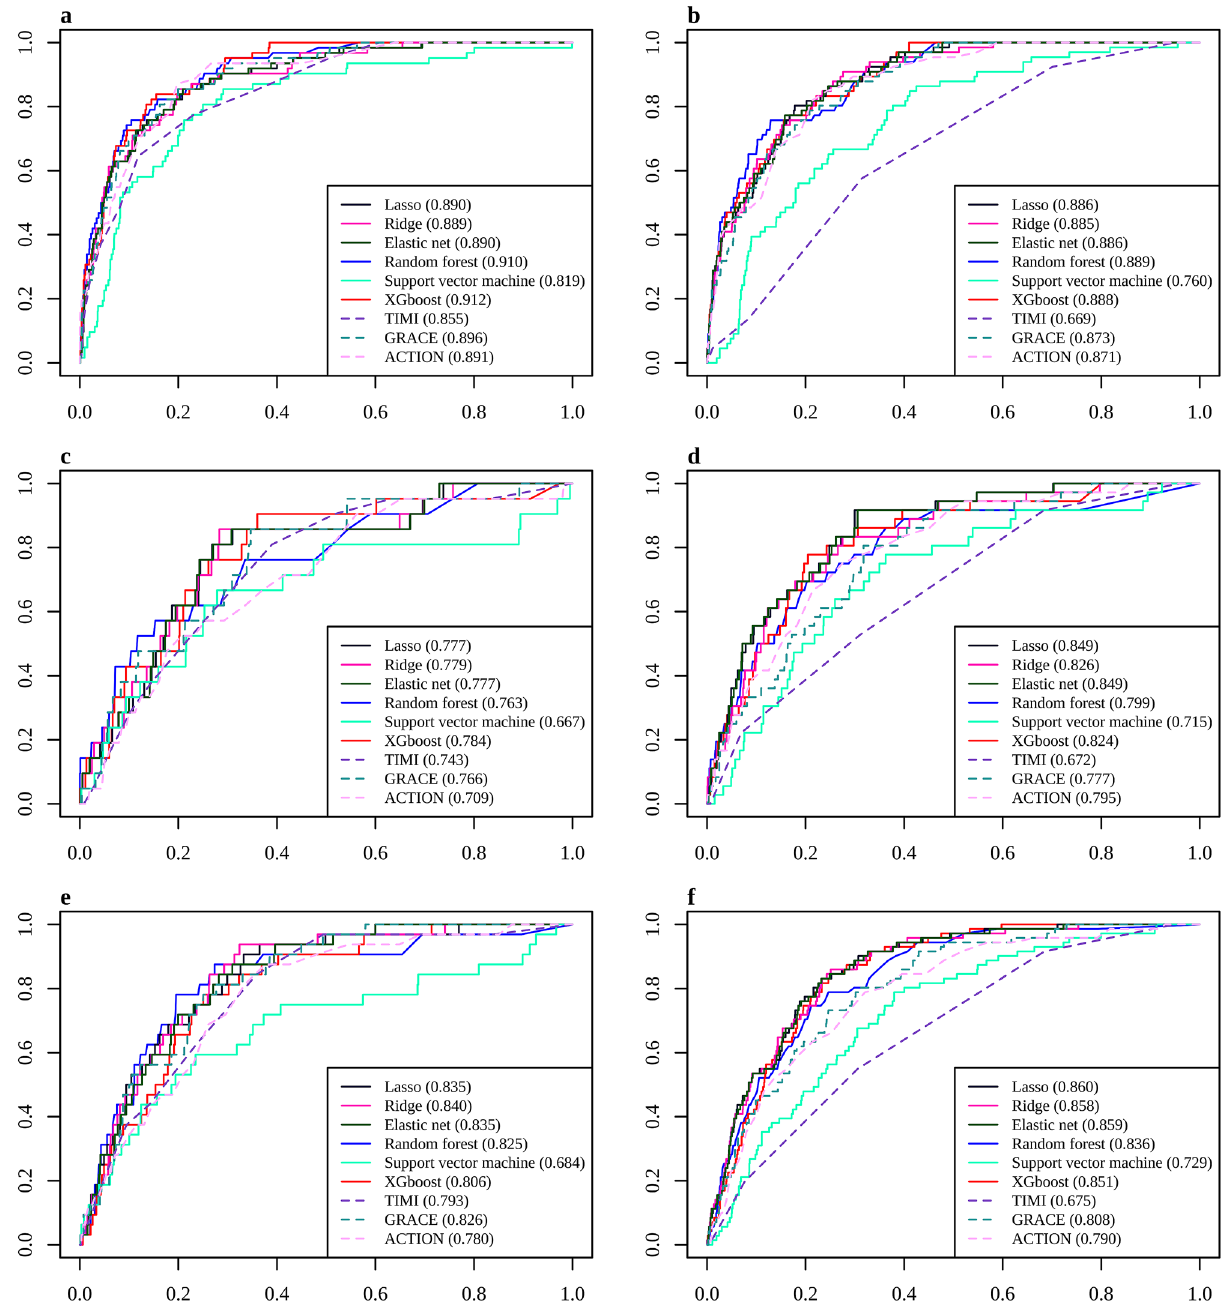
Figure 1. ROC curves of the in-hospital, three-month, and 12-month mortality prediction models in acute myocardial infarction with the traditional predictors. ( a ) In-hospital mortality in STEMI, ( b ) In-hospital mortality in NSTEMI, ( c ) three-month mortality in STEMI, ( d ) three-month mortality in NSTEMI, ( e ) 12-month mortality in STEMI, ( f ) 12-month mortality in whereas the corresponding numbers were 0.889, 0.849, and 0.860 in the ML model including the traditional predictors. None of the ML models, except for the SVM, showed a significant difference in the AUCs when the performance of the models with the traditional predictors only was compared with the model applying all the predictors. Moreover, a comparison of the ML models, including the traditional and optional predictors, and the corresponding models, including medication at discharge, showed no significant difference in both STEMI and NSTEMI (Supplementary Table 6). Supplementary Tables 7 and 8 list the importance of the variables. The variable importance was differ- ent for each prediction model. Some variables in the traditional predictors in the ML models were excluded, whereas some of the optional variables were included. Furthermore, the performance of the predictive models did not change significantly in both STEMI and NSTEMI when the problem of class imbalance was addressed